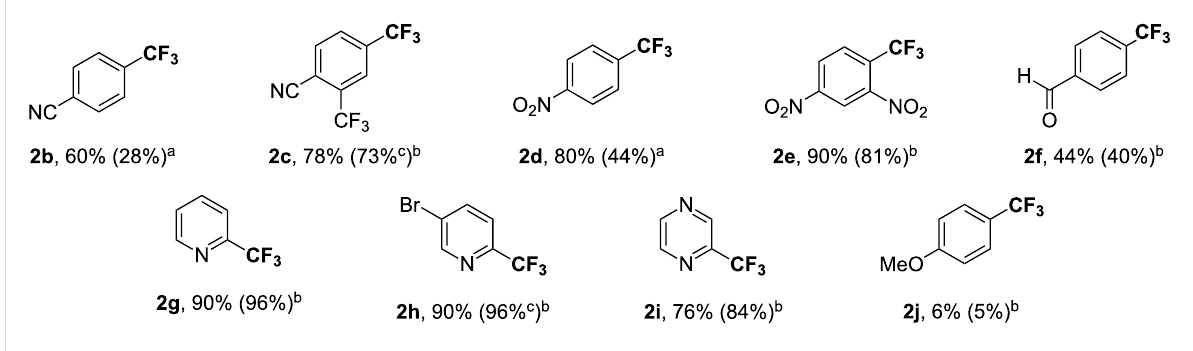
Figure 1: Copper-catalyzed trifluoromethylation of various aryl iodides. Yields were determined by 19 F NMR analysis by using benzotrifluoride as an internal standard. Values in parentheses are yields obtained under the reaction conditions without phen. Conditions: CF 3 I (2.5 × X equiv) and Zn dust (X equiv) in DMPU, then CuI (Y mol %), phen (Y mol %) and 1 (1 equiv) at 50 °C for t hours. a X = 4, Y = 2, t = 48. b X = 2, Y = 10, t = 24. c Isolated yields: 2c , 70%; 2h ,